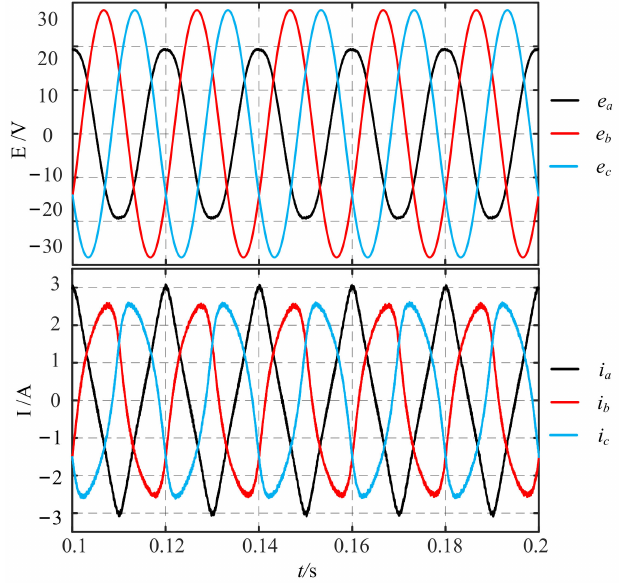
Figure 4. Waveforms of conventional FCS-MPDPC.